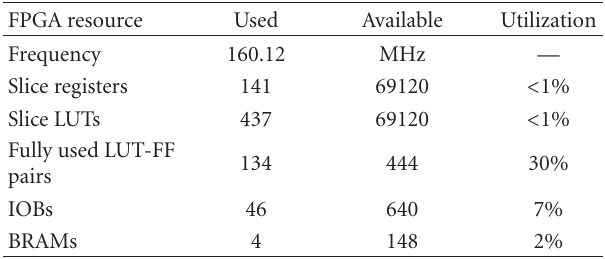
Table 1: Synthesis results of the ST/DDST